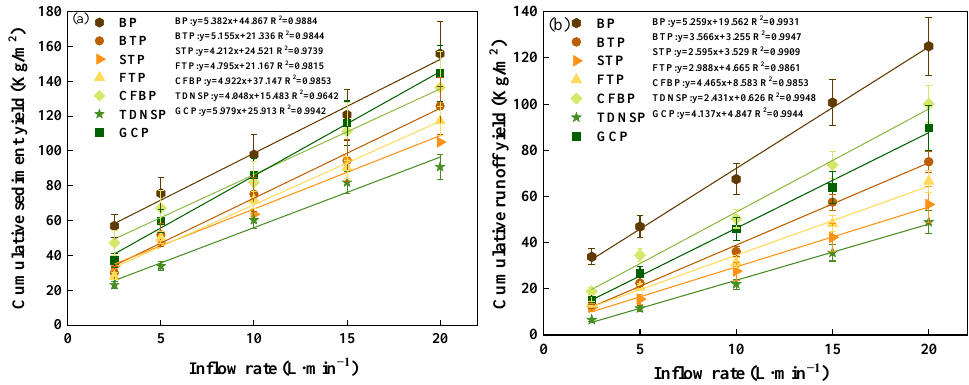
Figure 11. The influence of scouring inflow rate. ( a ) Relationship between inflow rate and cumulative sediment yield. ( b ) Relationship between inflow rate and cumulative runoff yield.